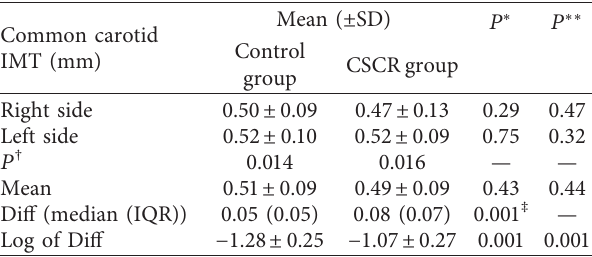
∗ Independent samples t -test. ∗∗ ANOVA test after adjusting for age, sex and body mass index. † Paired samples t -test. Diff, absolute value of the dif- ference between the two sides; IQR, interquartile range. ‡ Mann–Whitney